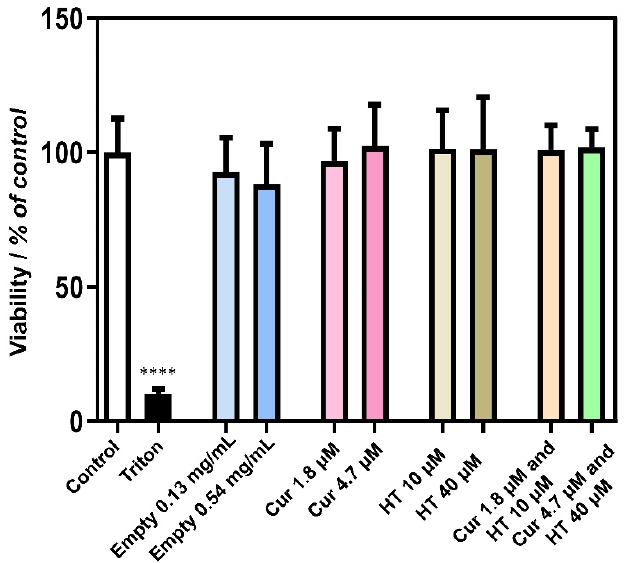
Figure 8. Effect of Type 3 (pH ≥ 7) liposomes on cell viability. Caco-2 cells were treated for 24 h with the noted concentrations of empty liposomes, Cur-liposomes (Cur), HT-liposomes (HT) and Cur/HT-liposomes (Cur/HT). Cell viability was determined as relative percent of viable cells of untreated control cells (control), put at 100%, by the MTT assay. Cells incubated with Triton X-100 (10% v/v ) were used as positive controls. Data represent means ± SD of 14–16 samples per condition, obtained in two different experiments. **** p < 0.0001 Triton vs. control.